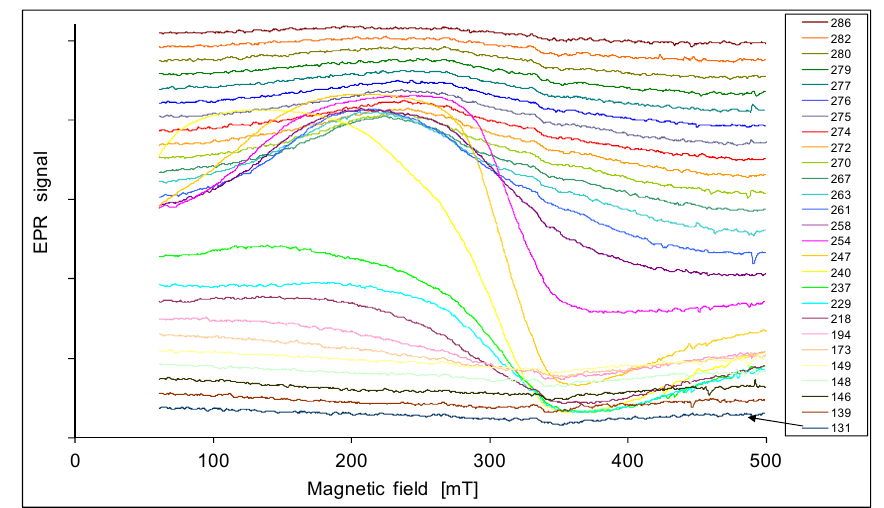
Figure 4. EPR spectra of the sample 4p at various temperatures in K.